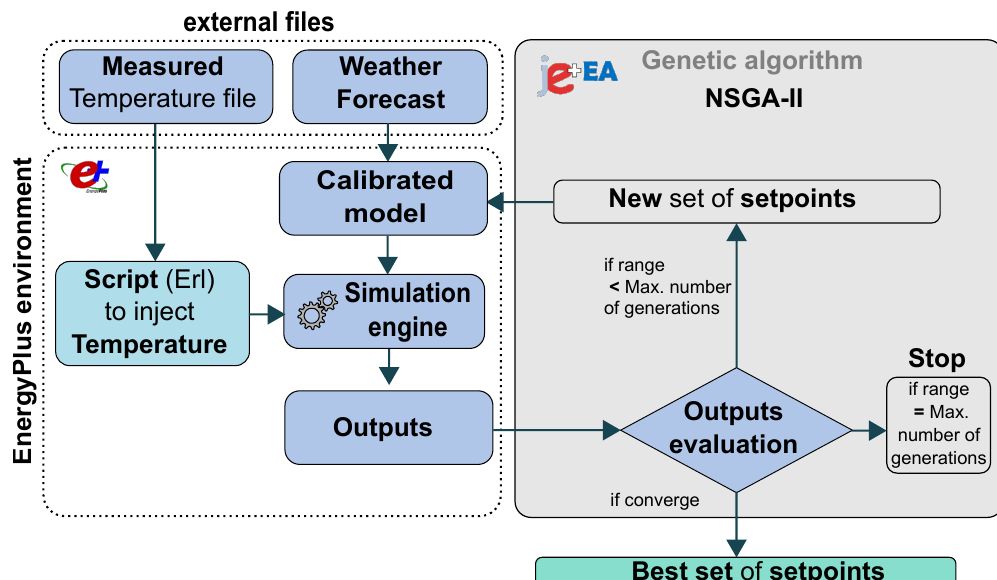
Figure 1. Model Predictive Control (MPC) general optimization